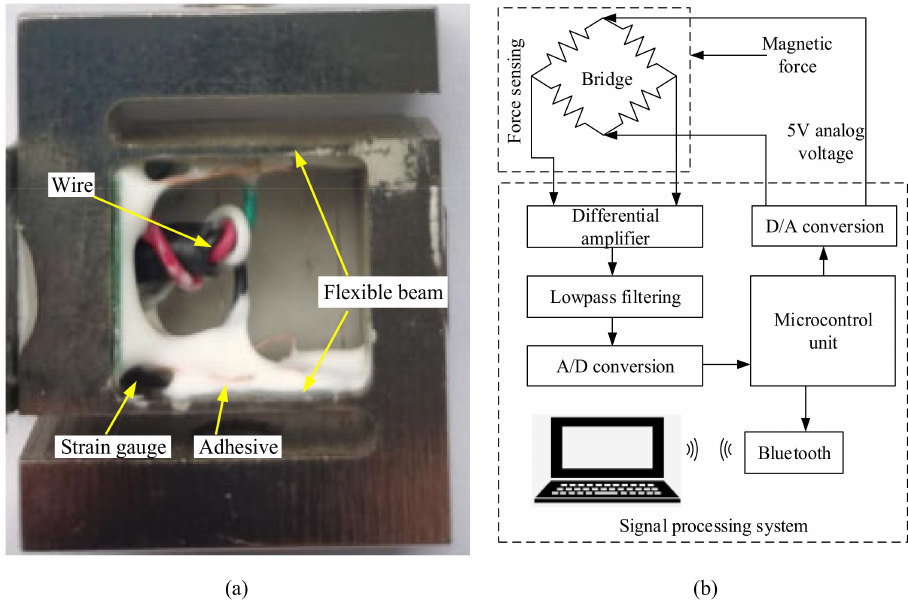
Figure 8. The manufactured force sensor and its signal processing scheme: ( a ) sensor; ( b ) signal